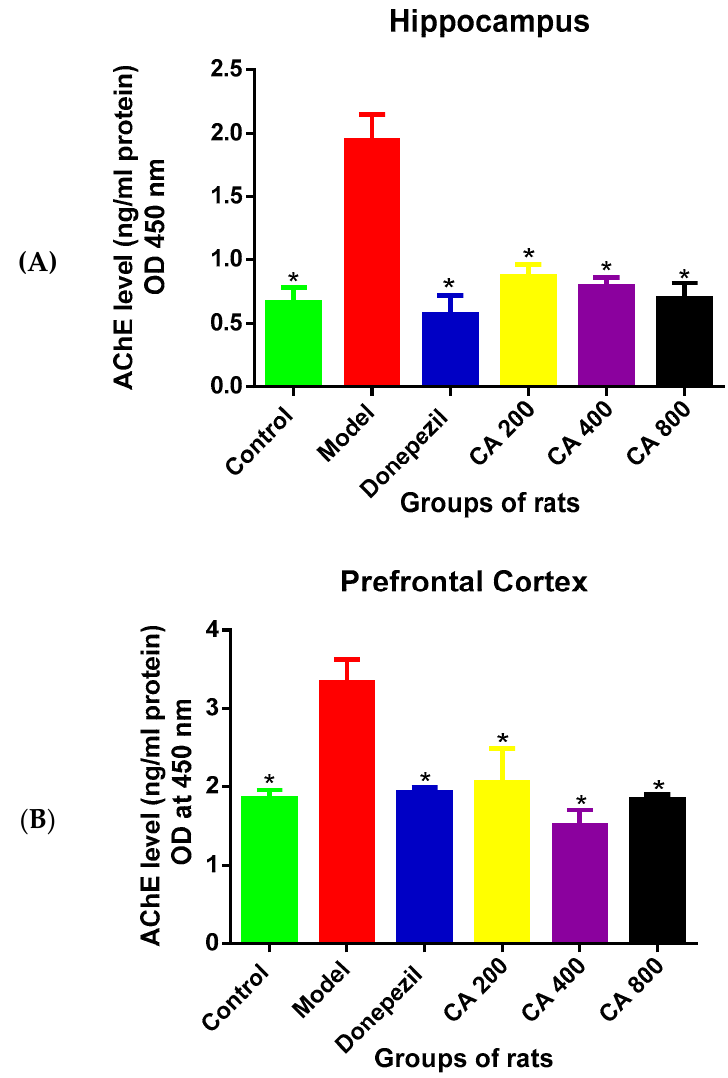
Figure 2. Effects of CA on acetylcholinesterase (AChE) levels. ( A ) Hippocampus, ( B ) cerebral cortex. Data were presented as mean ± SEM, n = 3. * p < 0.05 vs. model group.